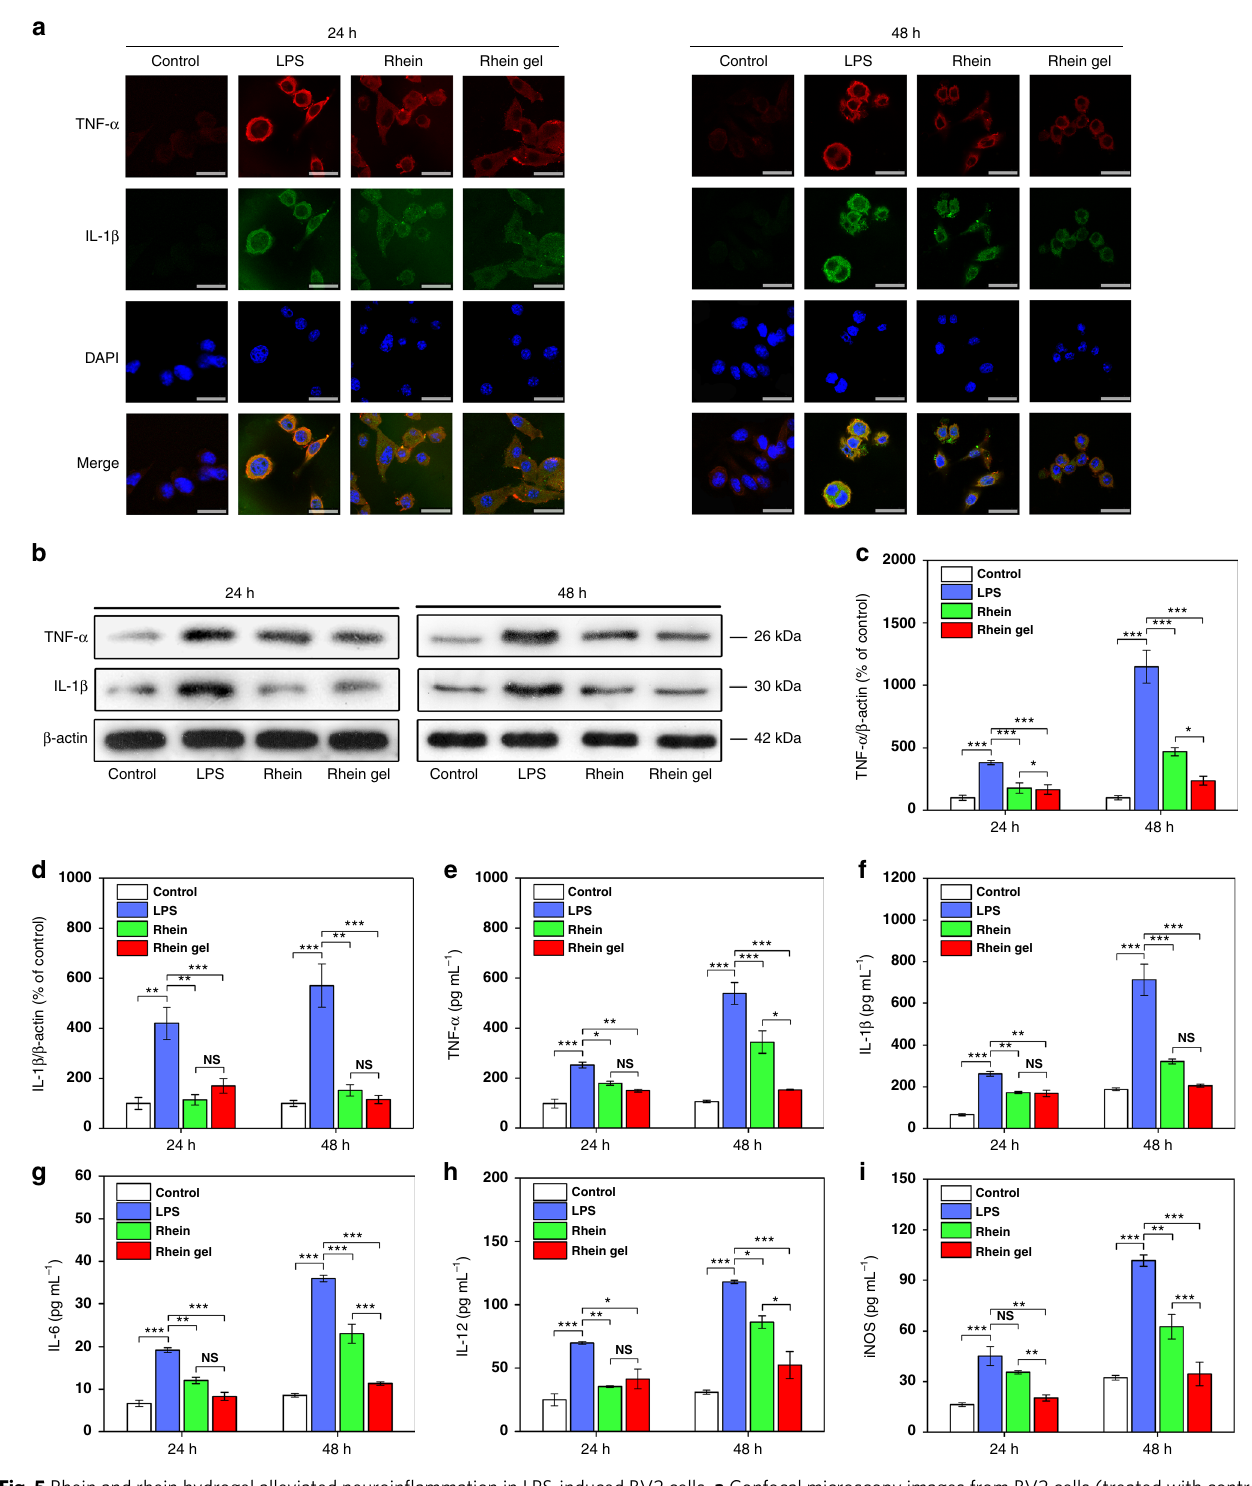
Fig. 5 Rhein and rhein hydrogel alleviated neuroin fl ammation in LPS-induced BV2 cells. a Confocal microscopy images from BV2 cells (treated with control, LPS, rhein and rhein hydrogel). Immuno fl uorescence staining is shown. Cell nuclei are shown in blue (DAPI), TNF- α is shown in red, IL-1 β is shown in green, and yellow labeling represents co-localization. Scale bar, 15 μ m. b Representative western blots of TNF- α and IL-1 β proteins at 24 h and 48 h. The uncropped and unprocessed scans of blots are presented in Supplementary Fig. 12. c Quanti fi cations of TNF- α at 24 h and 48 h. d Quanti fi cations of IL-1 β proteins at 24 h and 48 h. e – i ELISA assays for determinations of TNF- α ( e ), IL-1 β ( f ), IL-6 ( g ), IL-12 ( h ) and iNOS ( i ) levels at 24 h and 48 h. Values are expressed as means ± SEM ( n = 3). One-way ANOVA with Tukey ’ s post hoc test. * p < 0.05, ** p < 0.01, *** p < 0.001. Error bars represent